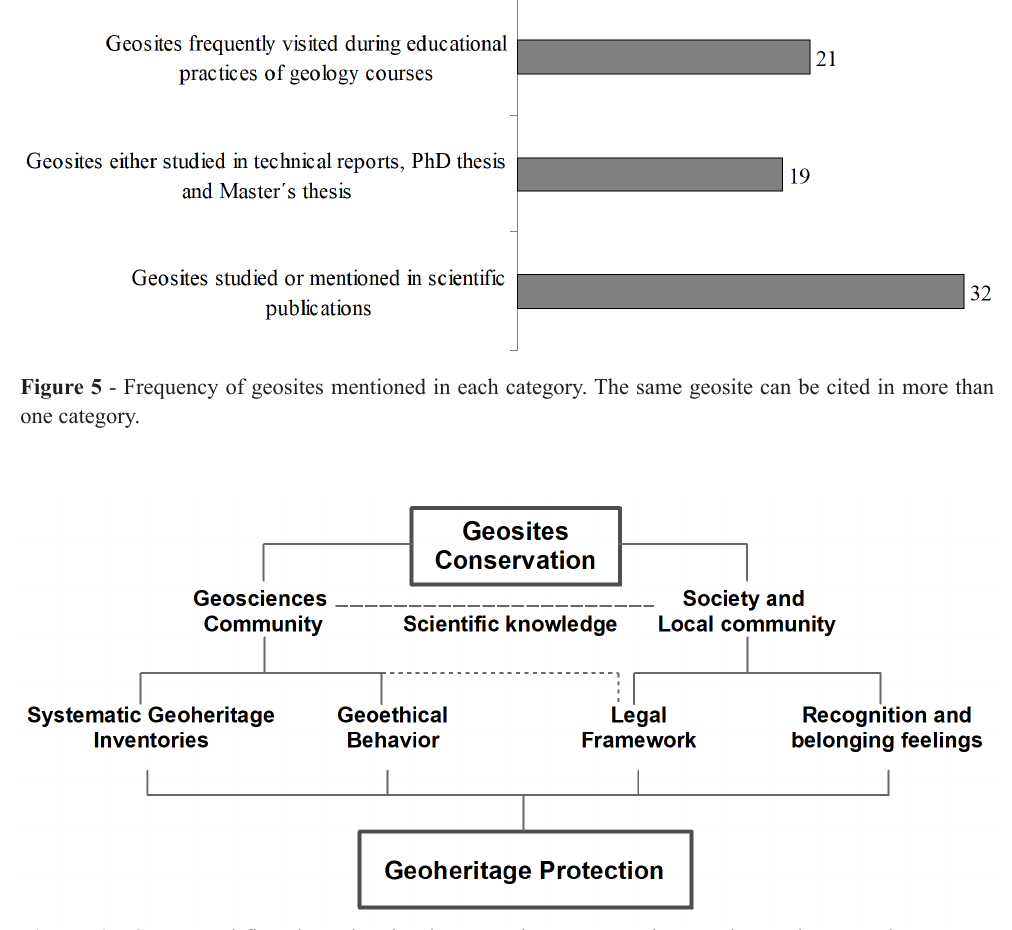
Figure 6 - Conceptual flowchart showing how geosites conservation can be used as a tool to protect geoheritage. Dashed lines indicate indirect